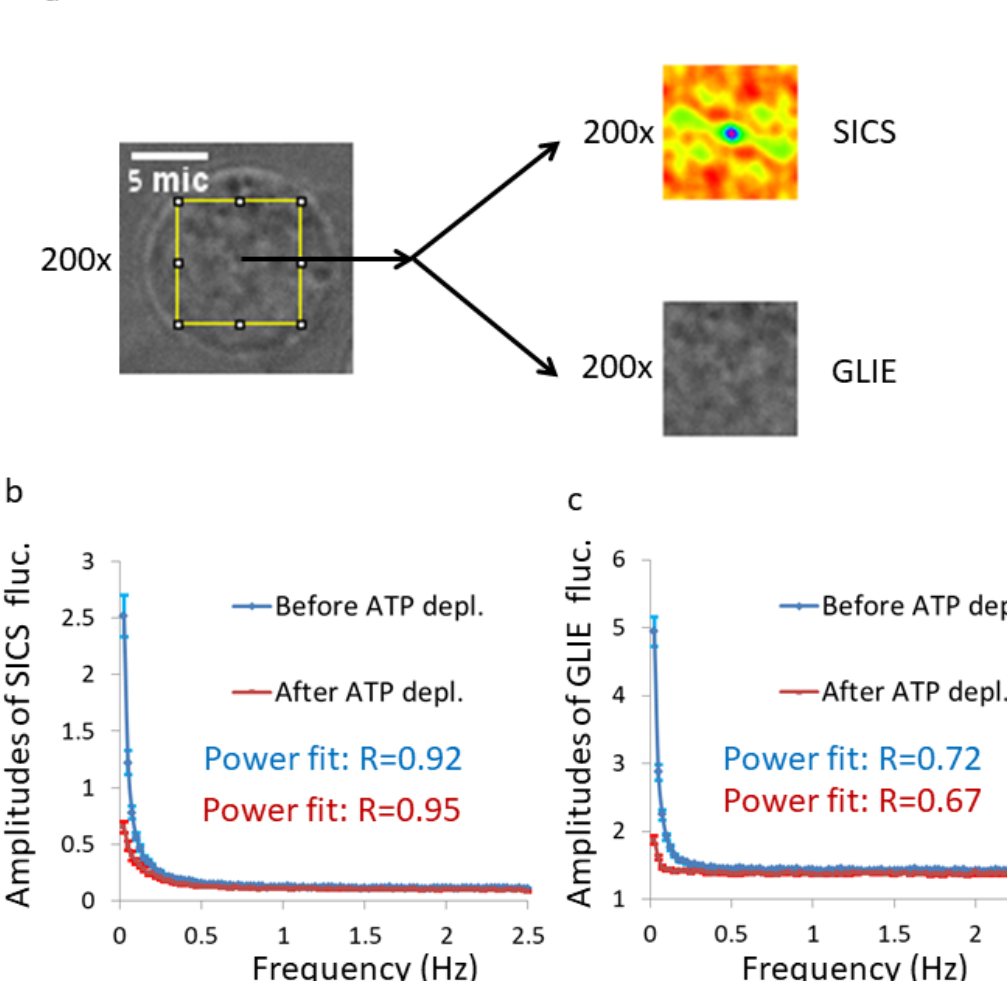
Figure 4. GLIE and spatial image correlation spectroscopy (SICS) fluctuations in Jurkat cells (n = 34) before and after ATP depletion. ( a ) An example of a Jurkat cell with the ROI of 50 × 50 pixels in its center. Serial 200 images in a time lag of 0.2 s were acquired for each cell. In that region of interest (ROI), SICS and GLIE values for each image were calculated as explained in the Material and Methods section. Average amplitudes of discrete Fourier transform (DFT), of SICS ( b ) or of GLIE ( c ) time-dependent fluctuations (Amplitude Spectral Density (ASD)) in the group of cells are plotted before and after ATP depletion. Power-fit R-values for each condition are presented. Error bars in panels b and c are SEM.